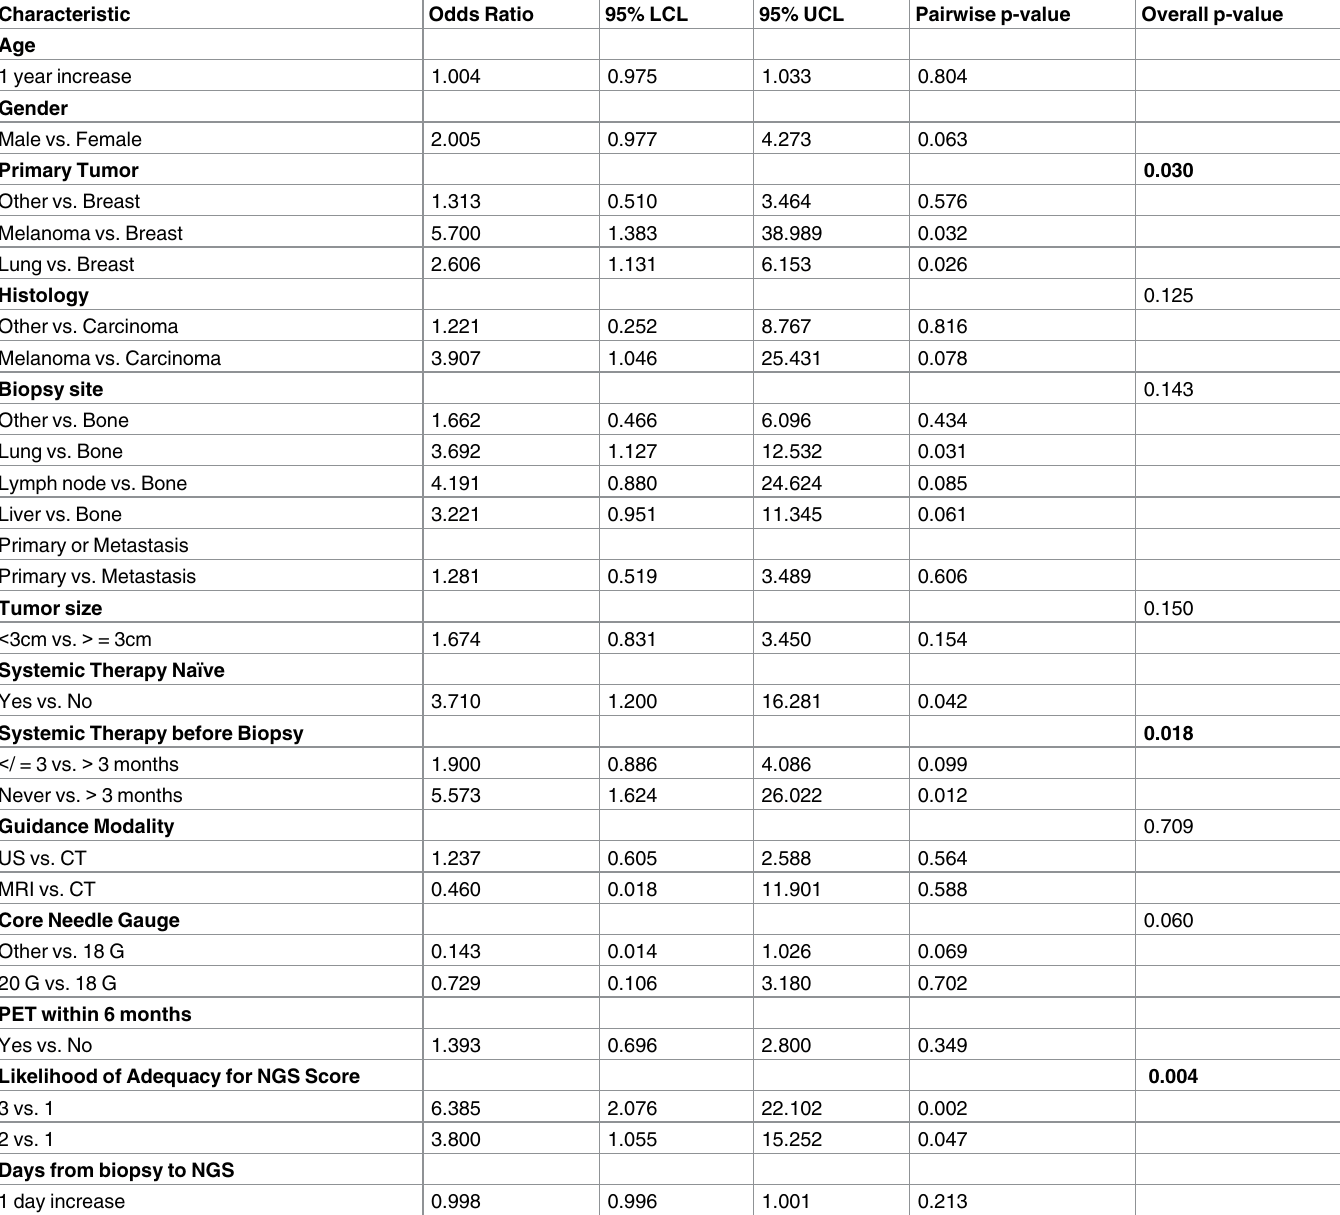
Table 4. Univariate logistic regression model of characteristics associated with adequacy for NGS of biopsy specimens.